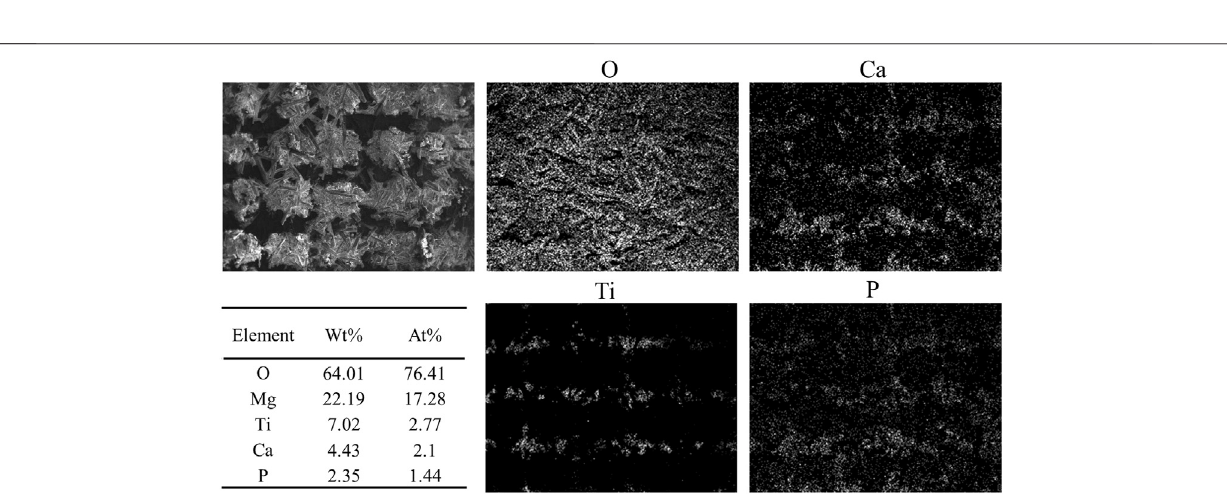
Frontiers in Bioengineering and Biotechnology |